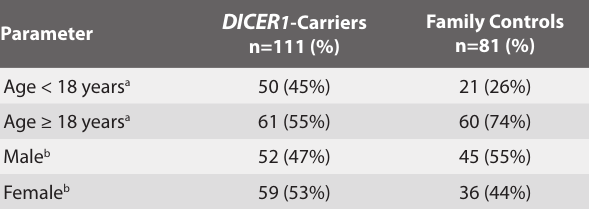
Table 1. Demographics of 192 DICER 1 -carriers and control individuals. DICER 1 -Carriers Parameter n=111 (%)